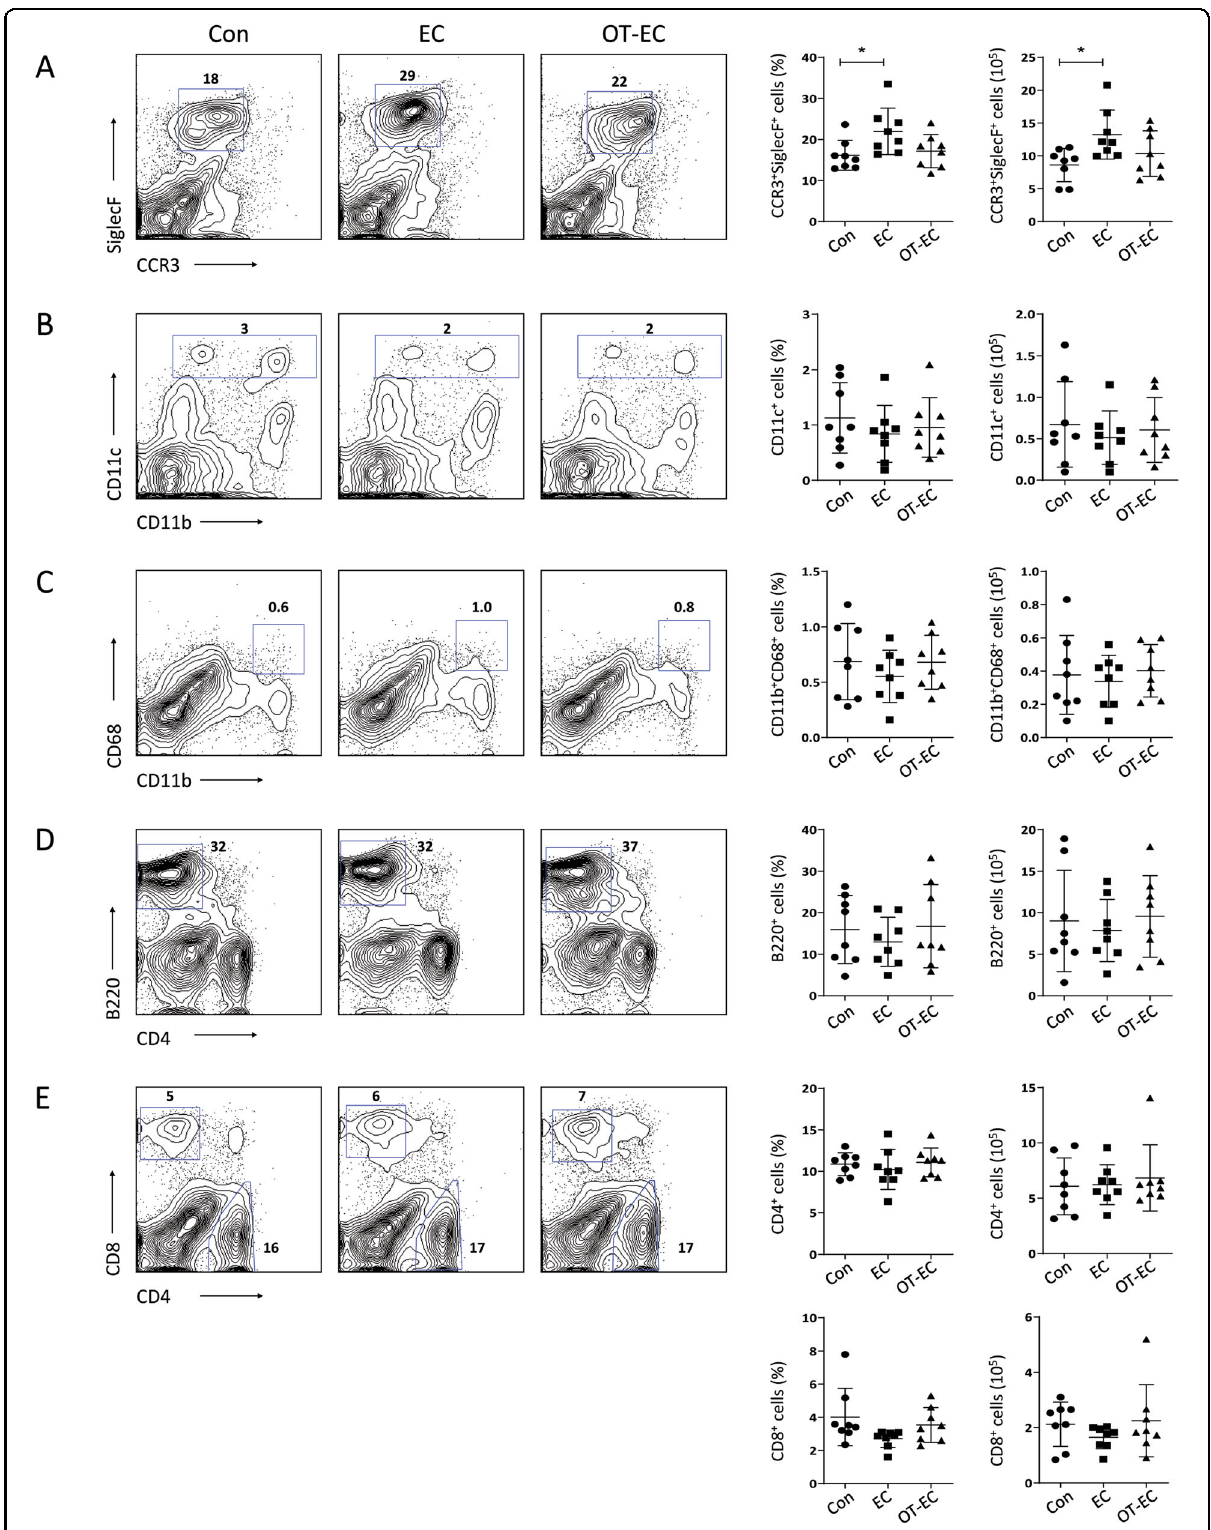
Fig. 4 Oral tolerance inhibited the in fi ltration of the small intestinal eosinophils elicited by EC challenge. A – E Representative fl ow cytometric plots, percentage, and cell count of eosinophils A , dendritic cells B , macrophages C , B cells D , and CD4 + and CD8 + T cells E in the small intestine of the indicated mice. The plots are gated on CD45 + cells and are representative of two independent experiments. The graphs show the mean ± SD values. * P < 0.05 (one-way